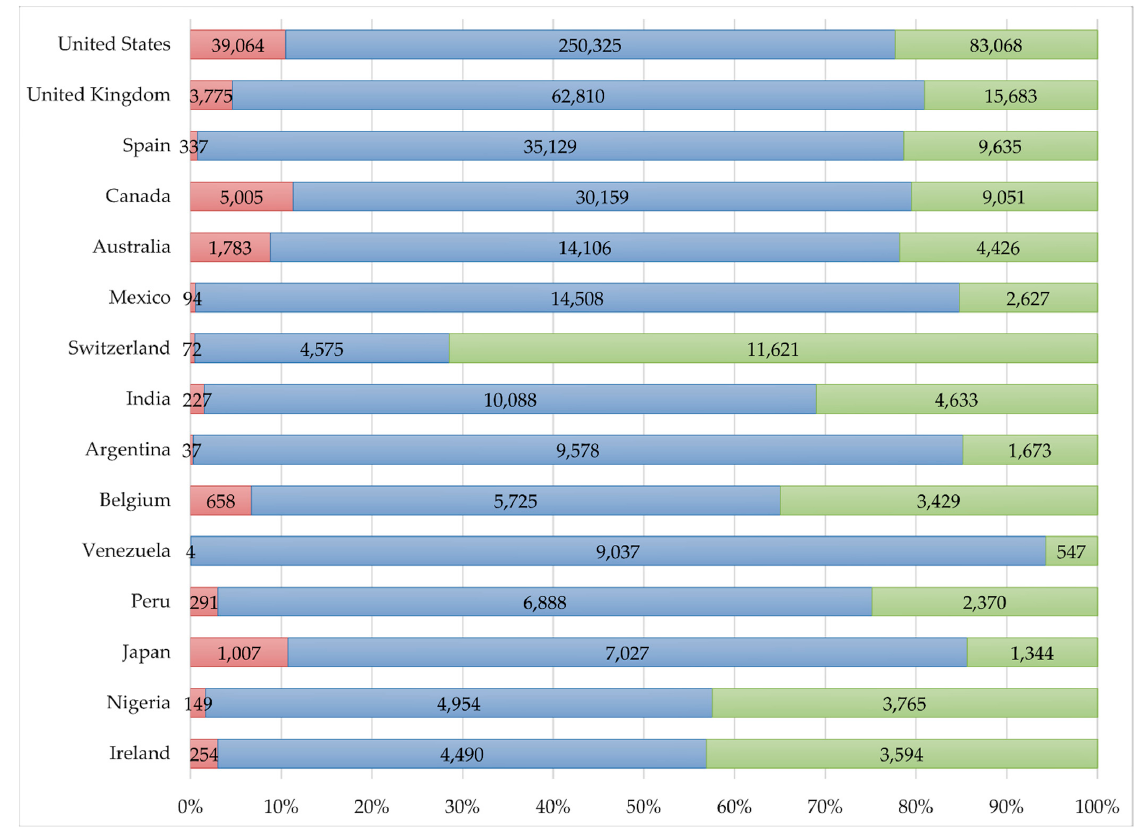
Figure 3. Absolute and relative number of tweets by sentiment polarity and location (June 2011–April 2019).